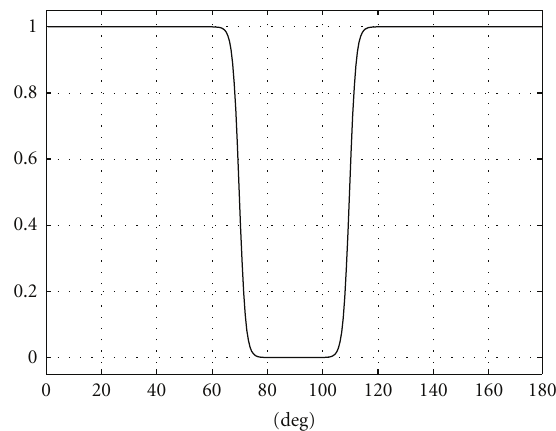
Figure 1: The masking function employed in the proposed